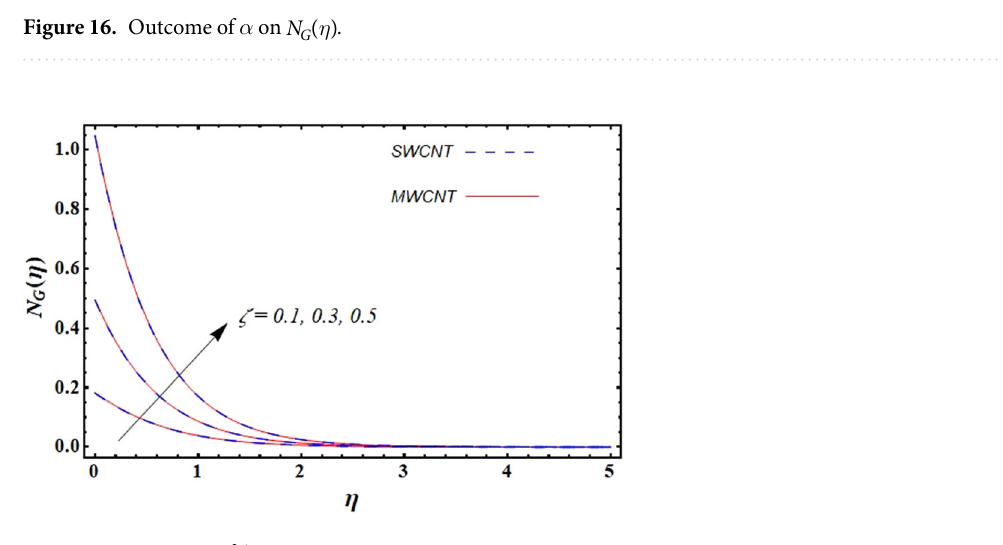
Figure 17. Outcome of ζ on η N ( )